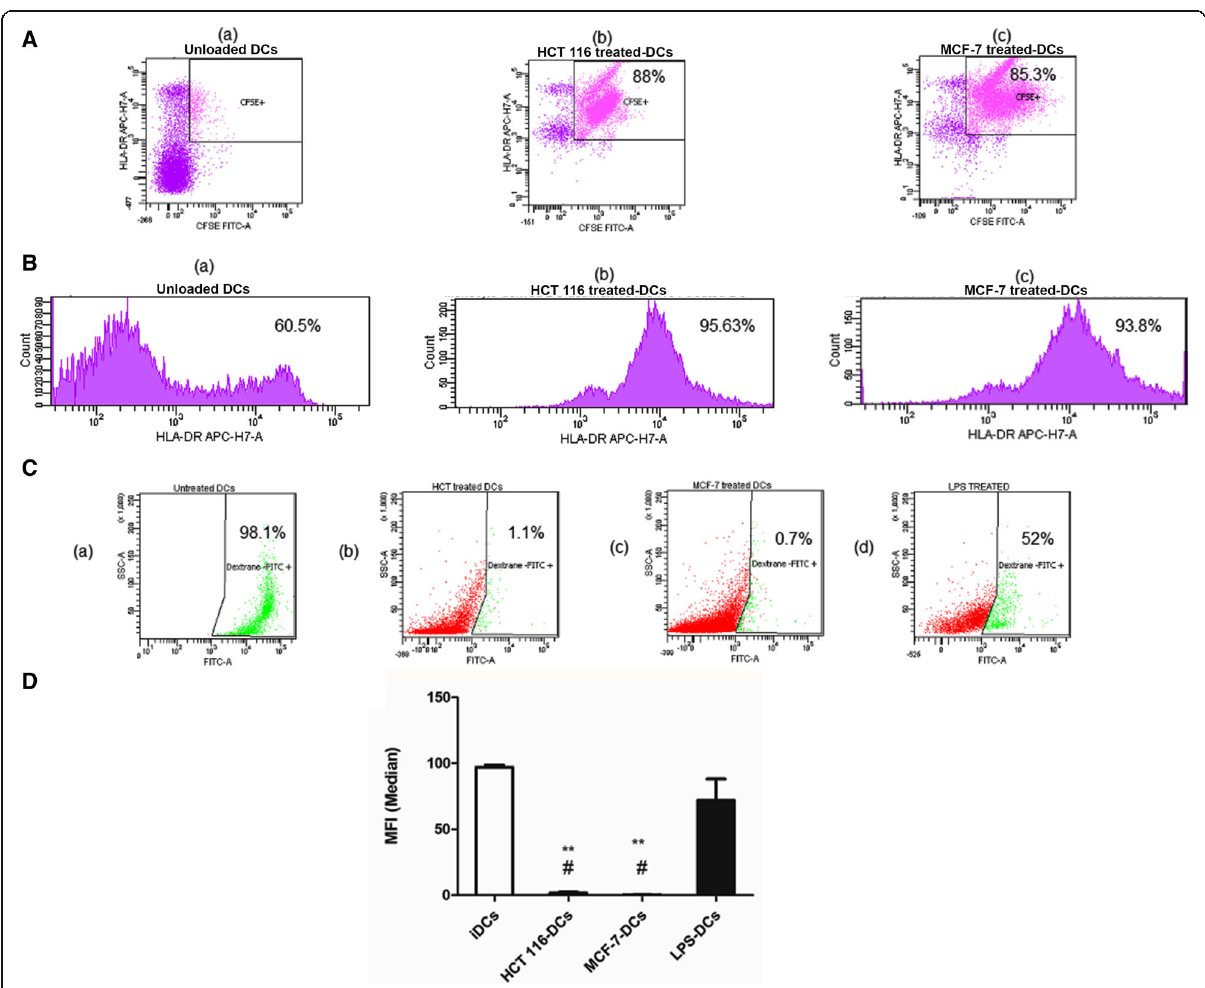
Fig. 3 The phagocytic capacity of dendritic cells towards CFSE-labeled tumor debris and FITC-dextran. a Flow cytometric analysis indicates the percentage of DCs population with positive uptake of CFSE stained tumor cell remnants in (a) iDCs, (b) HCT 116 treated-DCs and (c) MCF-7 treated-DCs. b Identification of DCs as high HLA-DR + population for (a) unloaded iDCs, (b) HCT 116-treated-DCs and (c) MCF-7-treated-DCs. c Representative FACs analysis data for FITC-dextran uptake by (a) iDCs, (b) HCT 116-TLY-pulsed-DCs, (c) MCF-7-TLY pulsed-DCs, and (d) LPS – stimulated only DCs. d The figure represents the statistically transformed data. ** Indicates significant difference (** P < 0.01) for TLY-treated-DCs versus iDCs. ## Indicated significant difference (## P < 0.01) of TLY-DCs versus LPS-stimulated DCs. The data are representative of three experiments comprising three different healthy donors and analyzed by one-way ANOVA followed by Dunnett ’ s test. iDCs, immature dendritic cell; TLY, tumor lysate; CFSE, Carboxy-fluorescein succinimidyl